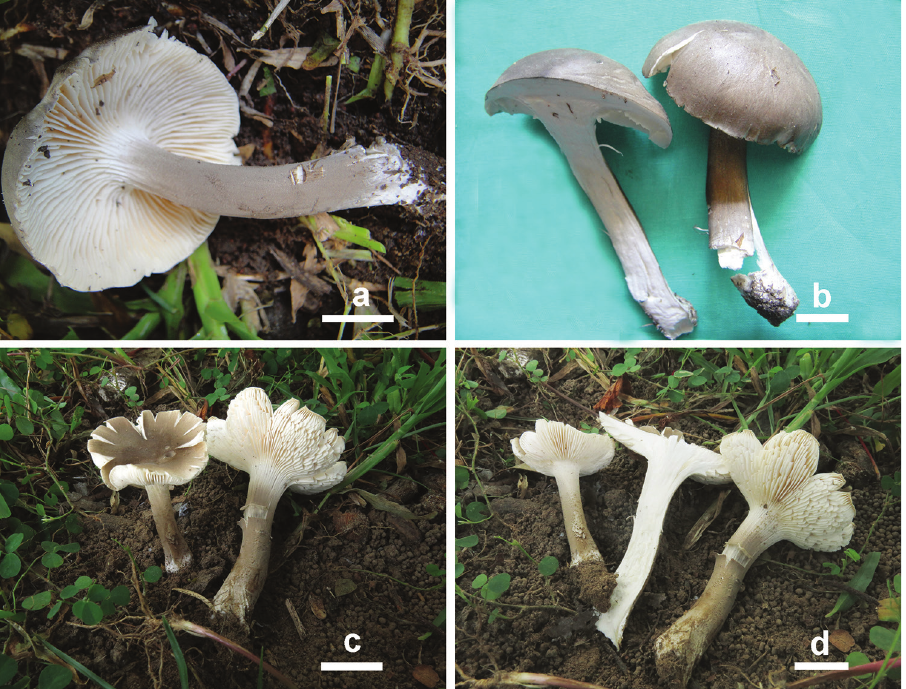
Figure 3. Basidiomata of Cantharocybe virosa . a, c Adnate-decurrent lamellae and pileus-stipe surface b, d Longitudinal section illustrating unchanged solid context a, b from HKAS 79012, Iqbal 568 c, d from Iqbal 693. Scale bars: 2